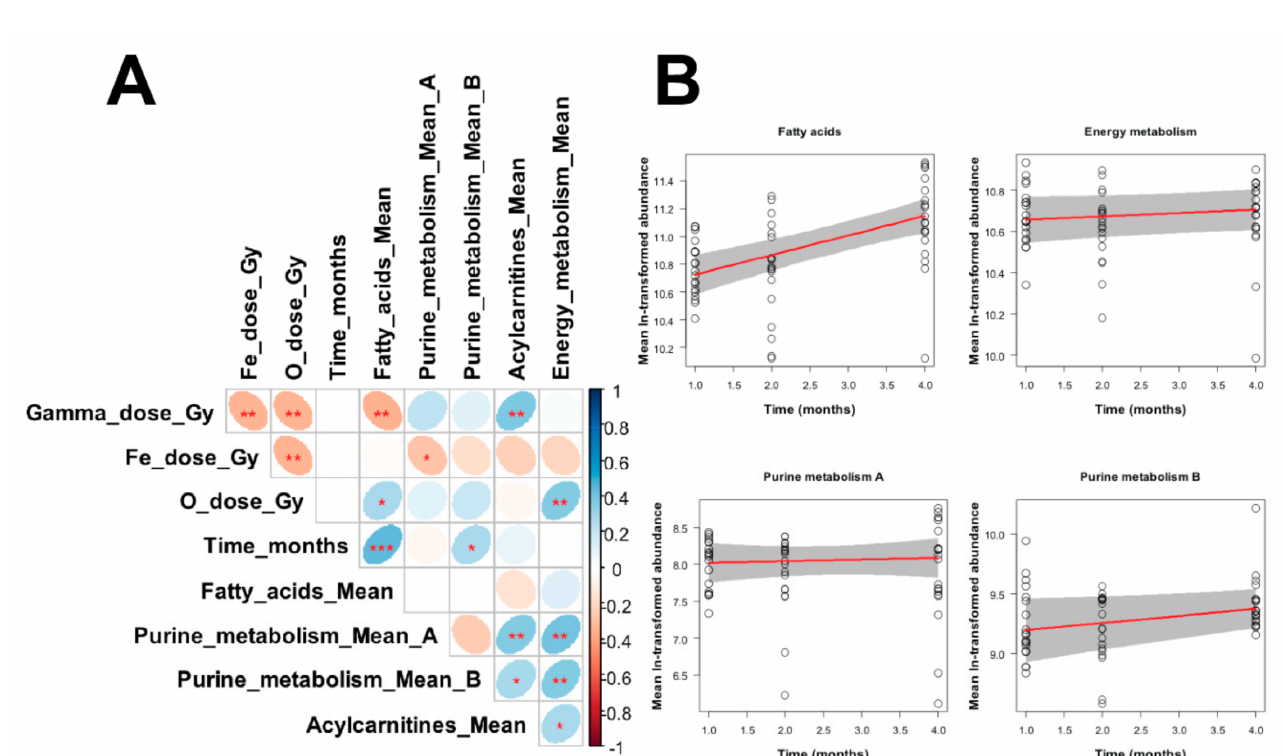
Figure 6. ( A ) Matrix of Pearson correlation coefficients between all variables in the analyzed data set. The meanings of all variables are provided in the main text, and a color-coded correlation scale is provided on the right of the plot. Blue ellipses represent positive correlations, and red ones represent negative correlations. Darker color tones and narrower ellipses represent larger correlation coefficient magnitudes. Red star symbols indicate statistical significance levels: *** indicates p < 0.001, ** indicates p < 0.01, * indicates p < 0.05, no stars indicates p > 0.05. These p values here are intended only for visualization: since the correlations are pairwise, without correction for multiple testing, only 3 star significance levels are likely to indicate strong associations. Blank squares indicate correlation coefficients close to zero. ( B ). Visualization of robust regression results for selected metabolite groupings vs. time after irradiation. Circles represent data points (mean ln-transformed signal intensities). Red lines represent regression fits, and grey shaded regions indicate estimated 95% confidence